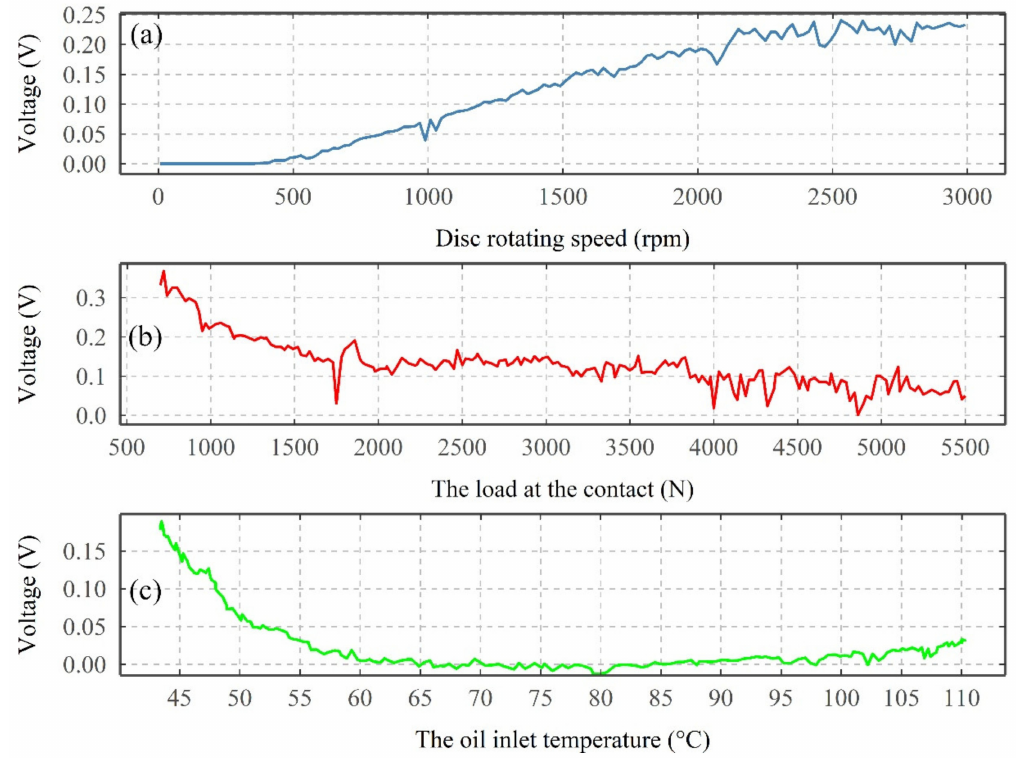
Figure 5. The average VADC under the influence of changing ( a ) the disc rotating speed, ( b ) the load at the contact, and ( c ) the oil inlet